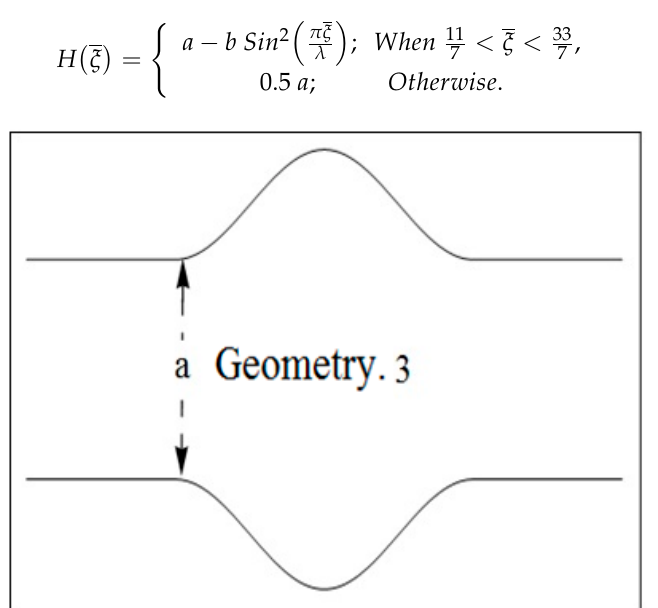
Figure 3. Physical sketch of the geometry.